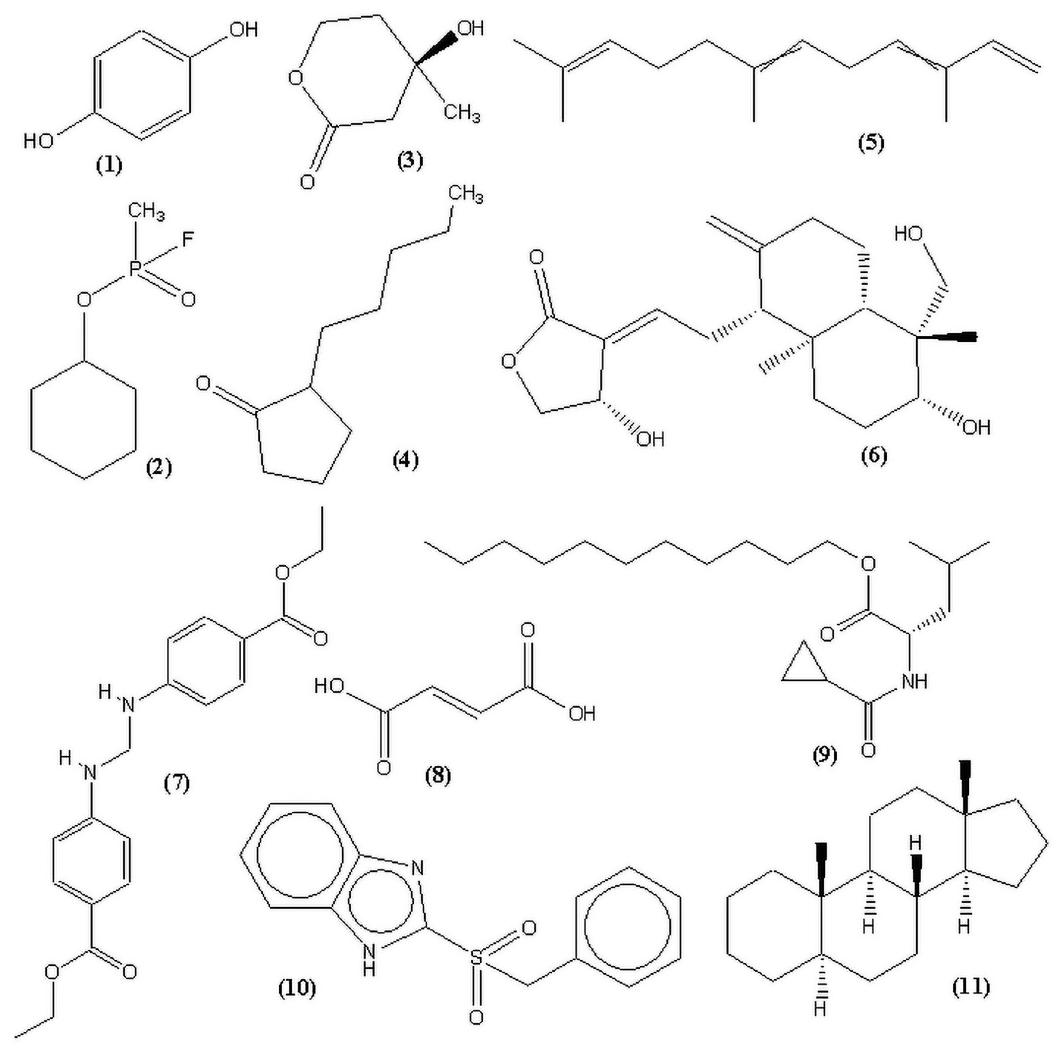
Fig 8. Chemical structures of constituents detected in IBSD-19